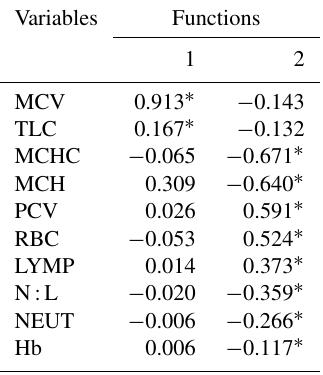
Asterisks ( ∗ ) indicate functions with significant loading. PCV, packed cell volume;